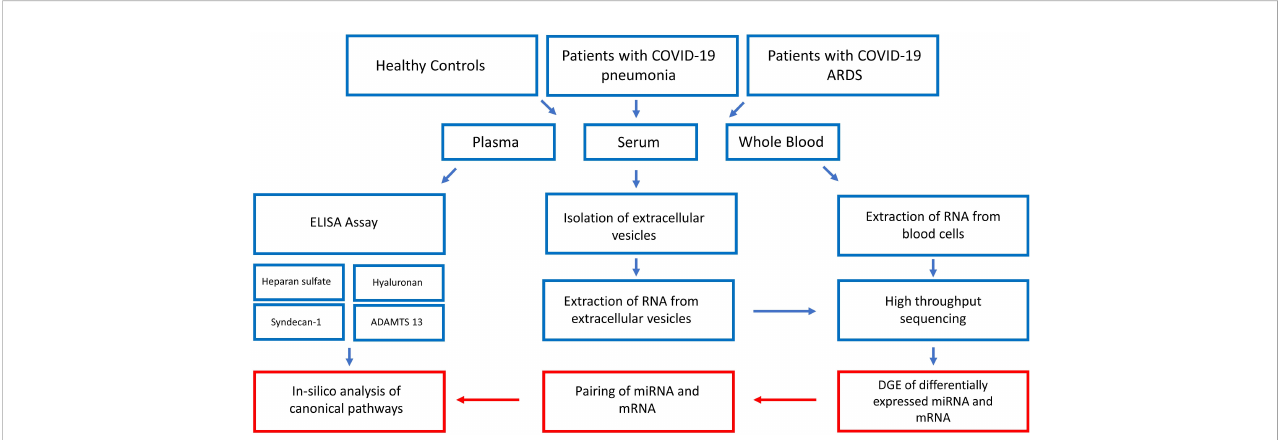
FIGURE 1 Step by step illustration of the study procedure. After recruitment of the study participants and blood sampling, plasma concentrations of glycocalyx components were measured by ELISA, EVs were extracted from serum and RNA extracted from EVs and whole blood cells followed by high-throughput RNA sequencing. The last step consisted of bioinformatic analysis resulting in the construction of glycocalyx component signaling networks in COVID- 19. ADAMTS13 = von Willebrand factor-cleaving protease, DGE, differential gene expression